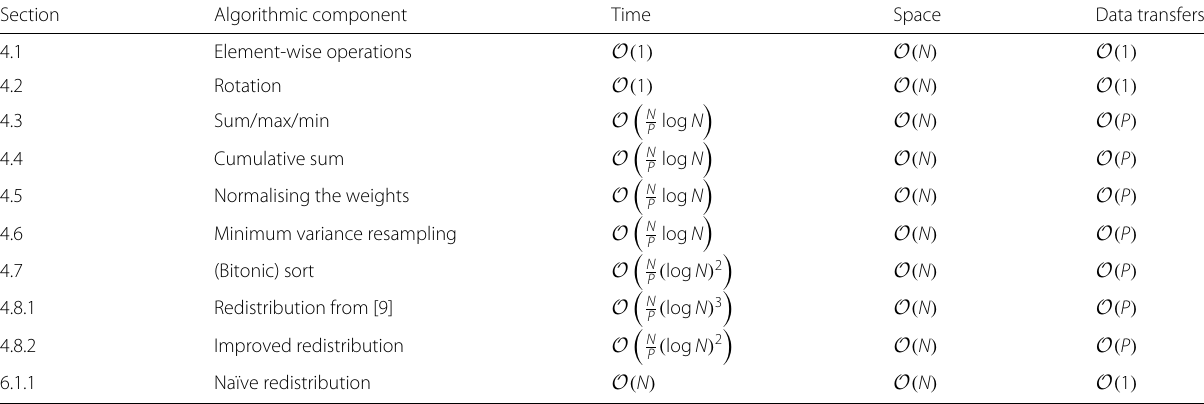
Table 1 Theoretical complexities (in terms of time, space and total data transfers per unit time) of various algorithmic components of the particle filter with N data and P processors Section Algorithmic